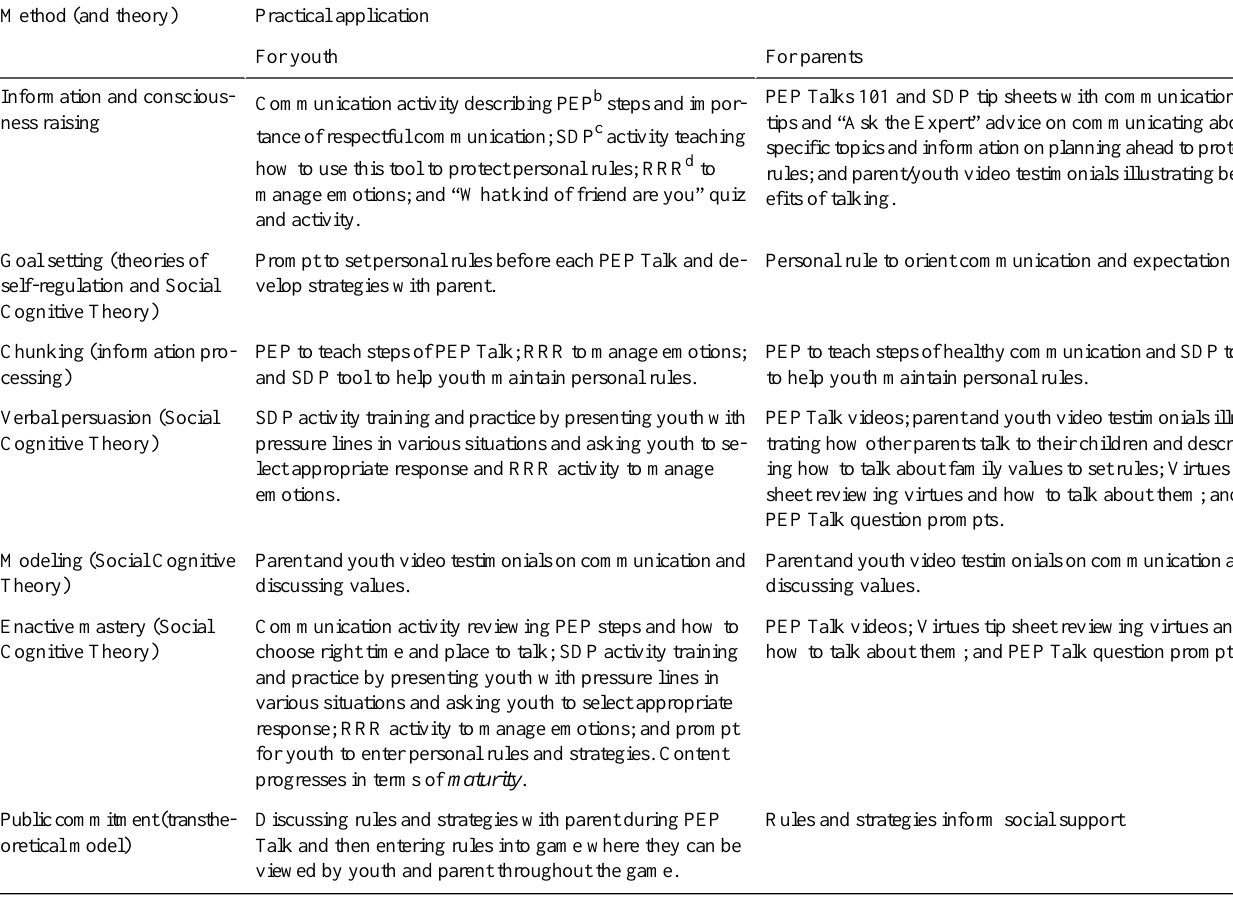
Table 4. Partial (example) matrix of methods and applicationsa.